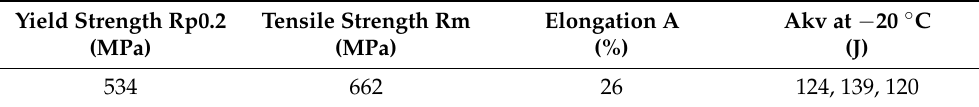
Table 3. Chemical composition of weld deposit. Grade C Mn Si S P Cr Ni Mo B Ti DW-S60G 0.07 1.68 0.33 0.006 0.011 0.02 0.77 0.26 / 0.02 Table 4. Mechanical properties of weld deposit. Yield Strength Rp0.2 Tensile Strength Rm Elongation A Akv at − 20 ◦ C (MPa) (MPa) (%) (J) 534 662 26 124, 139,